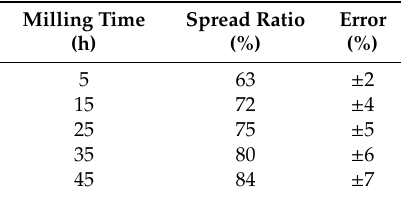
Table 5. The solderability of the Sn-0.7 wt. % Cu powder after various milling times. Milling Time Spread Ratio (h)